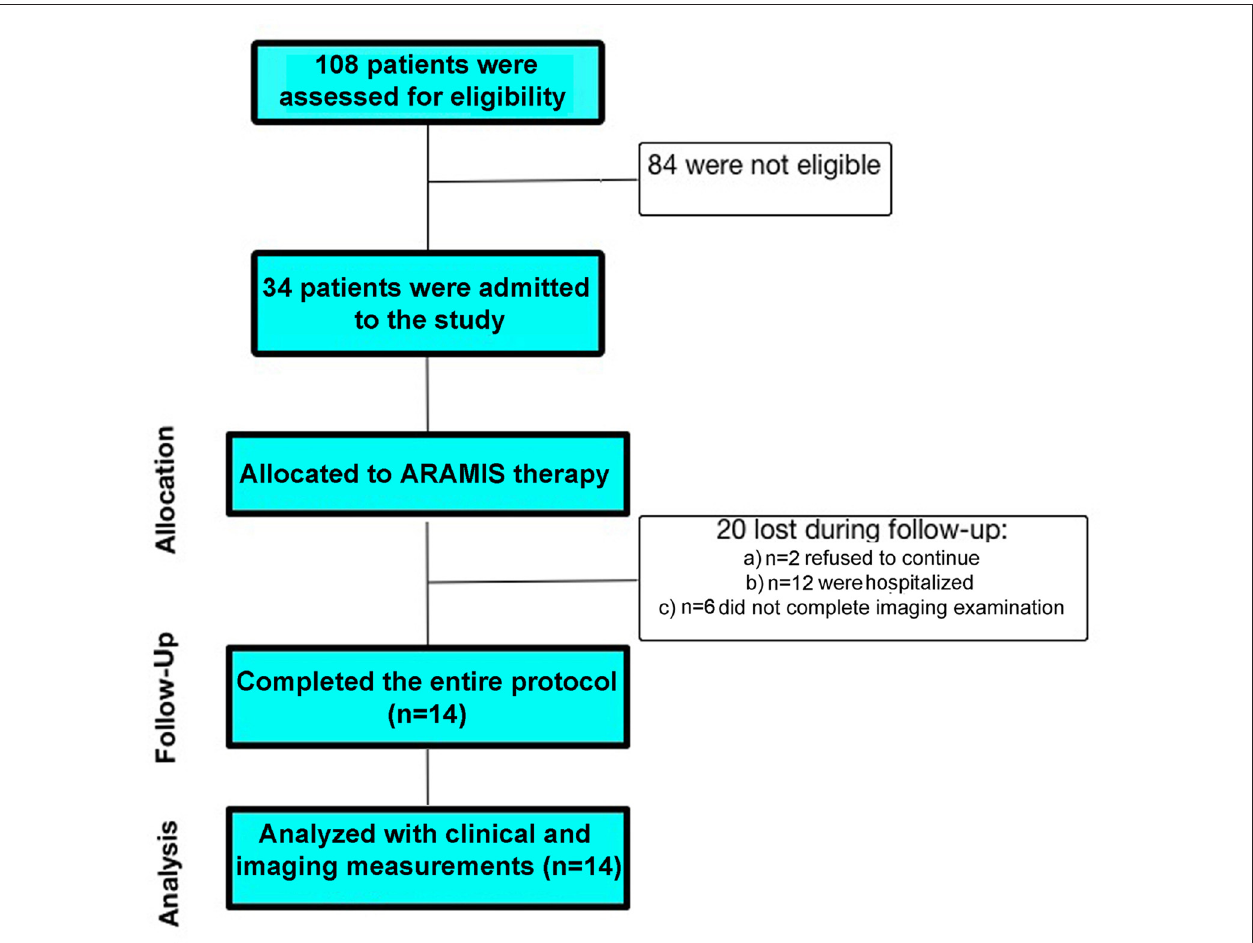
FIGURE 1 | Flow diagram of participant recruitment and participation in the study: stroke patients participated in an individualized robotic-assisted neurorehabilitation program (ARAMIS